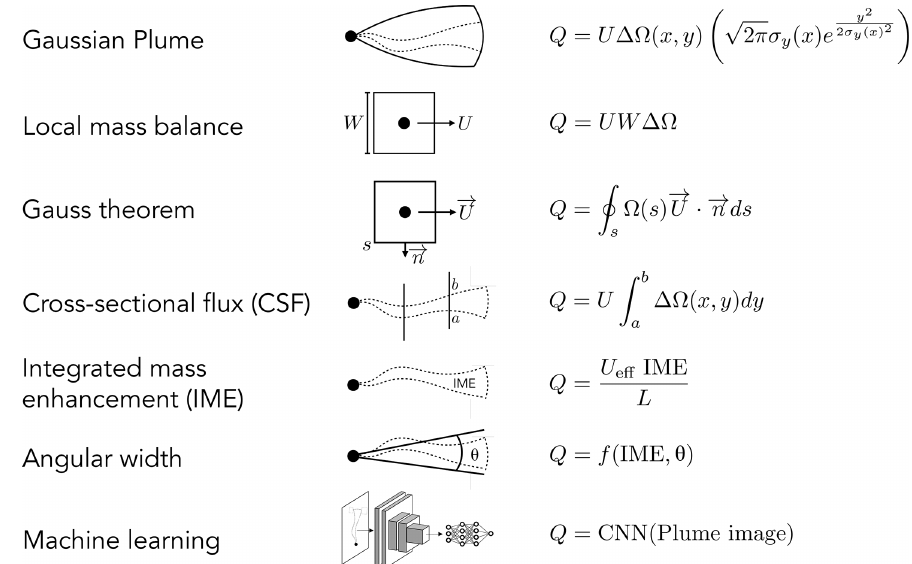
Figure 6. Seven different methods for inferring point source rates Q [kgs − 1 ] from satellite observations of instantaneous plumes of methane column enhancements (cid:49)(cid:127) [kgm − 2 ] relative to background. The methods involve (1) fit to a Gaussian plume, (2) local mass balance for near-source pixels, (3) Gauss theorem with integration of the outward flux along a closed contour s , (4) cross-sectional flux (CSF) integral, (5) integrated mass enhancement (IME) with independent wind speed information, (6) IME with wind speed inferred from the plume angular width θ , and (7) machine learning applying a convolution neural network (CNN) to the plume image. Methods (1), (2), (4), and (5) are described by Varon et al. (2018); method (3) is described by Krings et al. (2011); method (6) is described by Jongaramrungruang et al. (2019); and method (7) is described by Jongaramrungruang et al. (2022). In the equations, x denotes the plume axis for transport by the mean wind and y denotes the horizontal axis normal to the wind. The IME [kg] is the spatial integral of the methane column enhancement (cid:49)(cid:127) over the plume mask. The wind speed U is that relevant to transport of the plume, and in the IME method (4) it is parameterized as an effective wind speed U eff to include the effect of turbulent diffusion. The Gauss theorem and CSF methods require wind direction information. The IME method (4) requires a characteristic plume size L that can be taken as the square root of the plume area (Varon et al., 2018) or the radial plume length (Duren et al., 2019). The empirical dispersion parameter σ y [m] in the Gaussian plume method (1) characterizes the spread of the plume. n in the Gauss theorem method is the unit vector normal to the